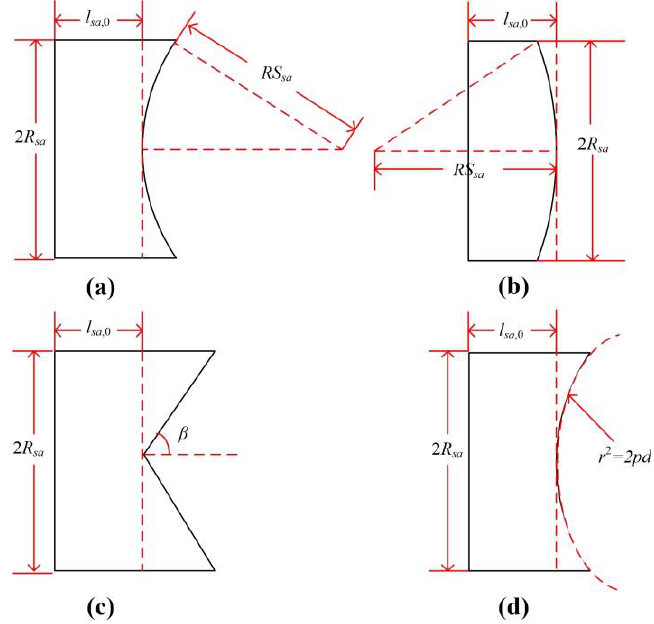
Figure 3. Four kinds of shapes of the saturated absorber. ( a ) the cylinder saturated absorber with one end cut as a spherical concave surface; ( b ) the cylinder saturated absorber with one end cut as a spherical convex surface; ( c ) the cylinder saturated absorber with one end cut as a conical surface; ( d ) the cylinder saturated absorber with one end cut as a parabolic surface.